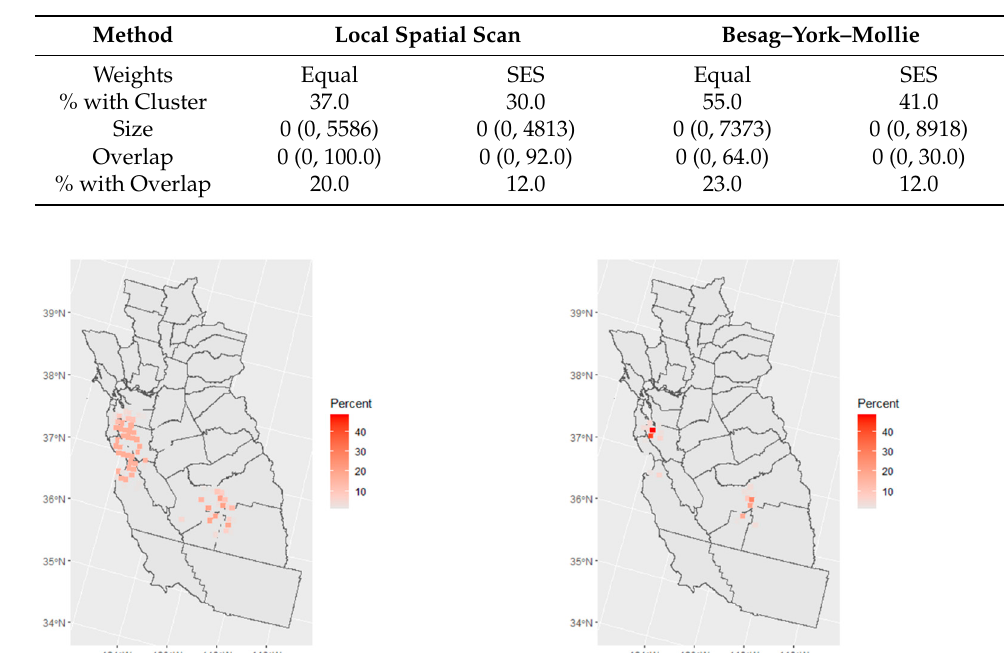
Figure 7. Percent of areas detected as significantly elevated risk over 100 simulated datasets from the first scheme using local spatial scan ( left ) and BYM model ( right ).